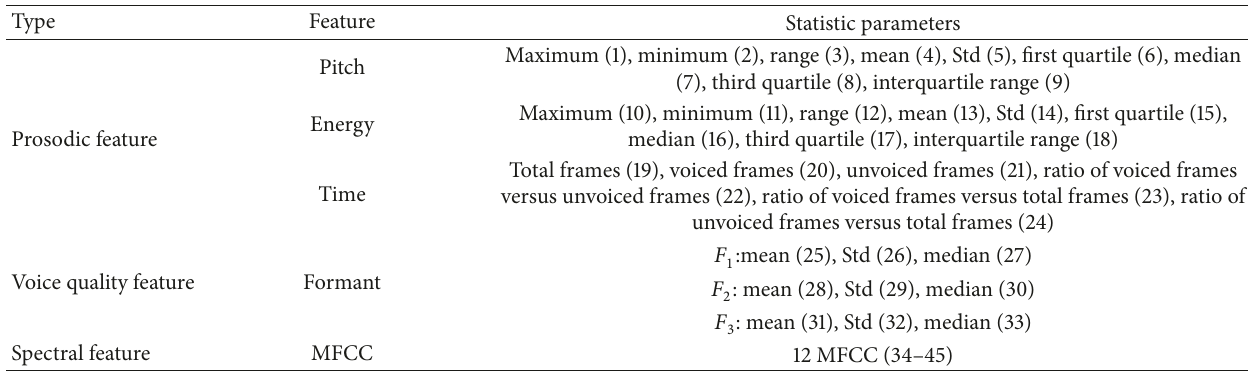
Table 1: Feature